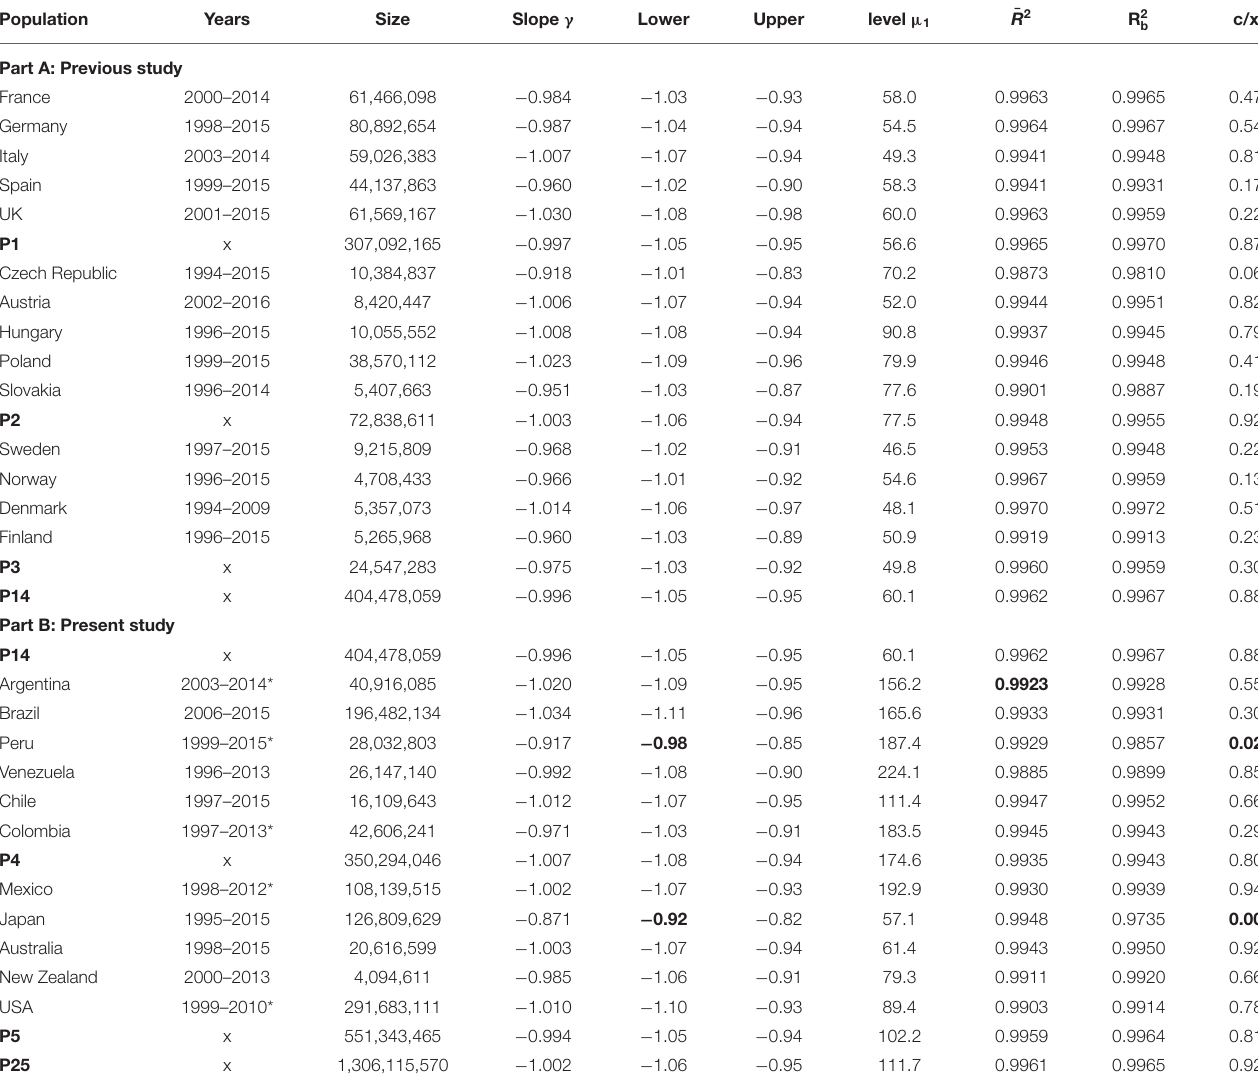
TABLE 1 | Population sizes and results of total mortality calculated during the first 10 years in all populations in the log-log scale.